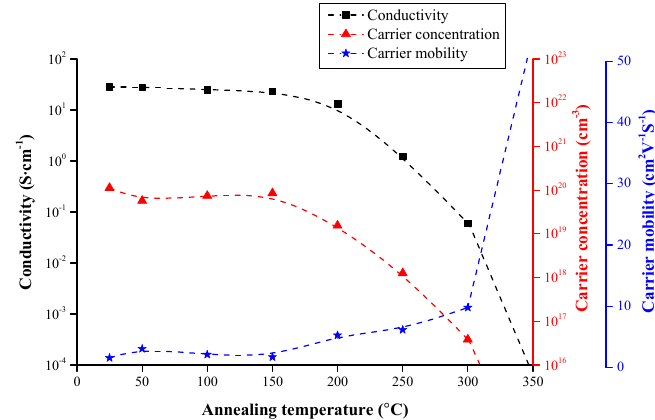
Figure 7. The electrical thermal stability of the ZnO film with 4.29 at. % Ga under normal atmospheric conditions.